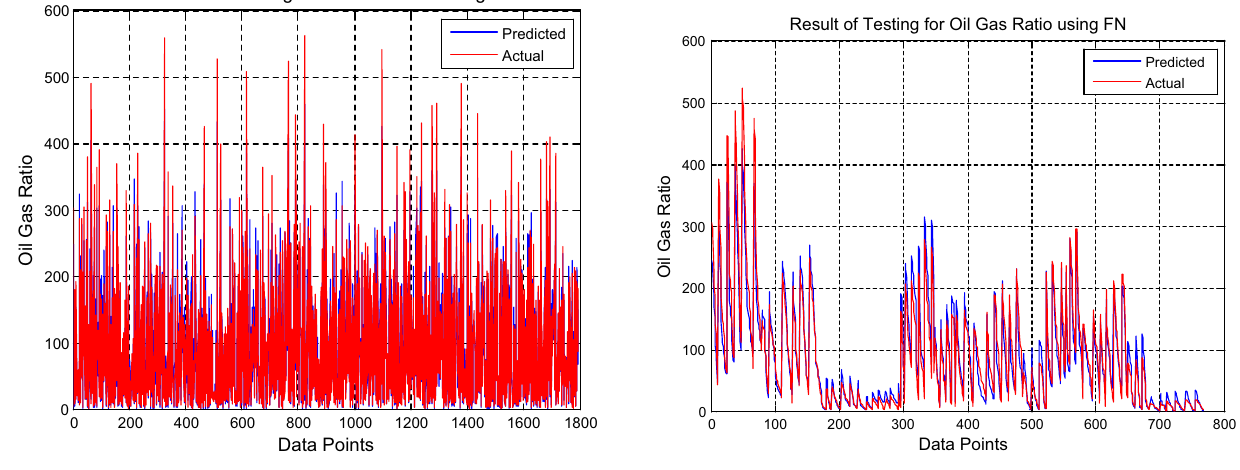
v as a function of data points using